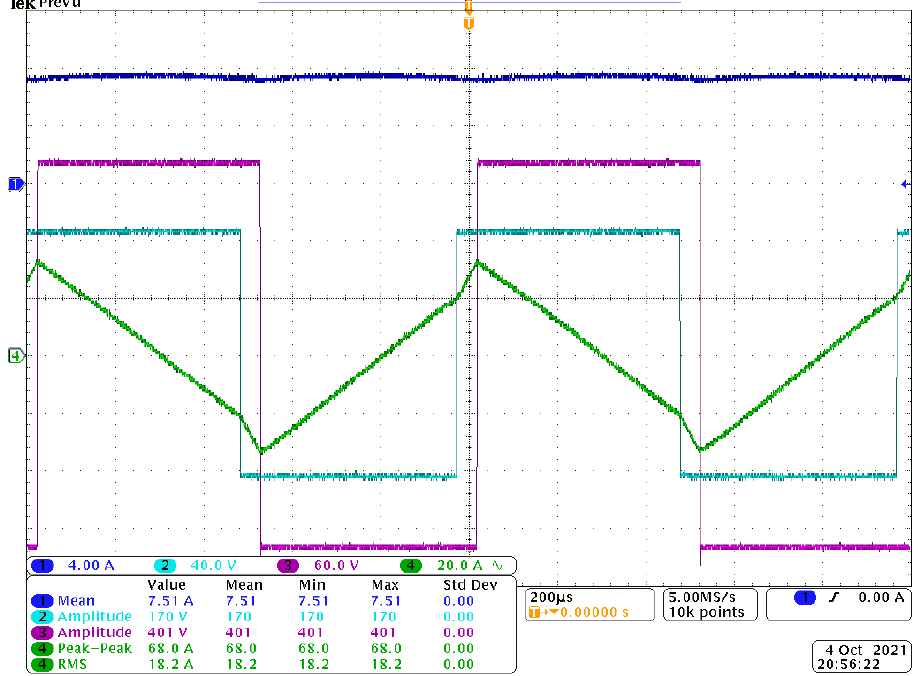
Figure 12. DAB operation at rated power under the SPS method.